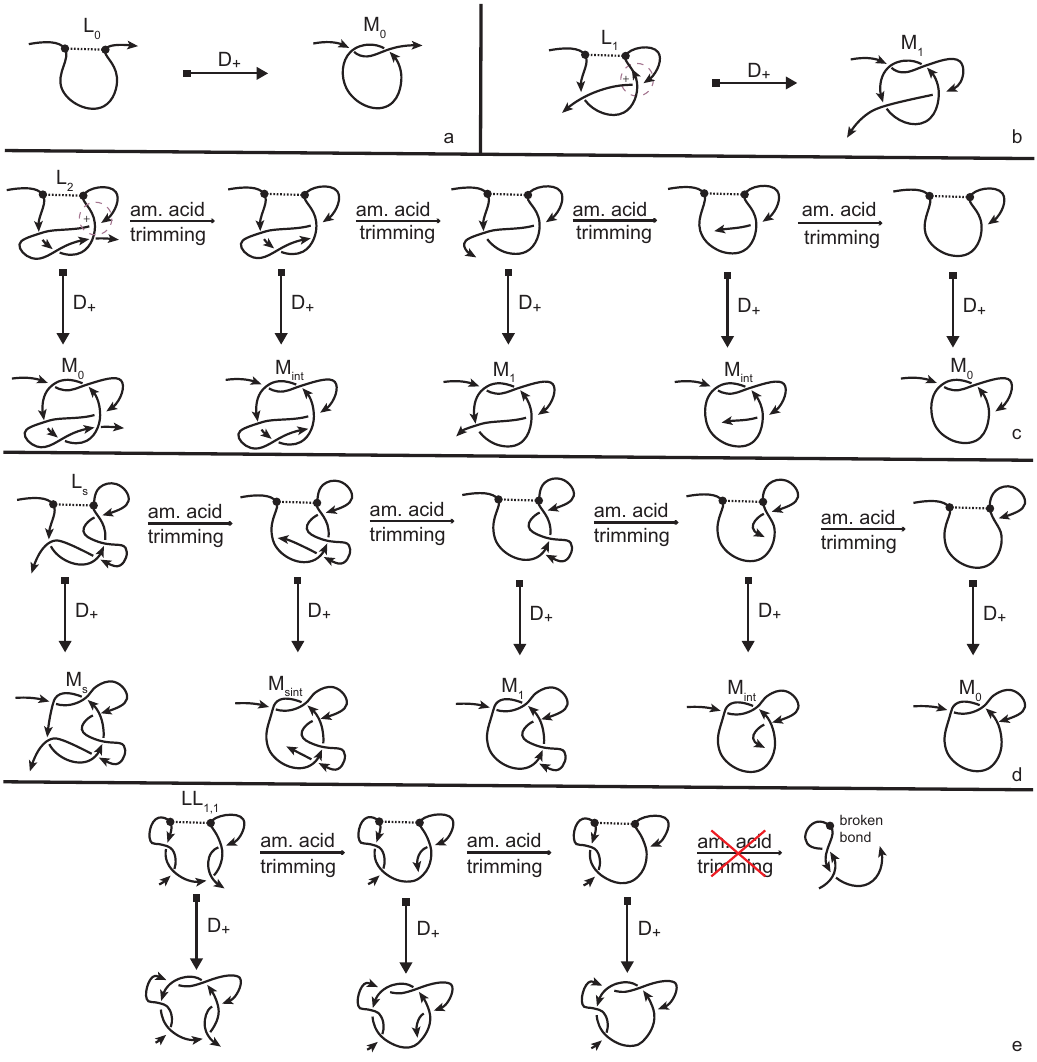
Figure 9. Distinguishing the lassos ( a ) L 0 ; ( b ) L 1 ; ( c ) L 2 ; ( d ) LL 1,1 ; and ( e ) L s . The crossing the determines the first piercing of the loop is positive and so a type D + insertion is performed on the lassos. The slipknot in L 2 is detected through progressive trimming of the C terminus of the three-dimensional curve and evaluating each resulting diagram, while the first two lassos are distinguished immediately by the insertion. Insertions in lassos ( d , e ) distinguish them from the types that were already discussed, but not from one another. Trimming the C terminus of the 3D chain leads to different substructures allowing, thus, their